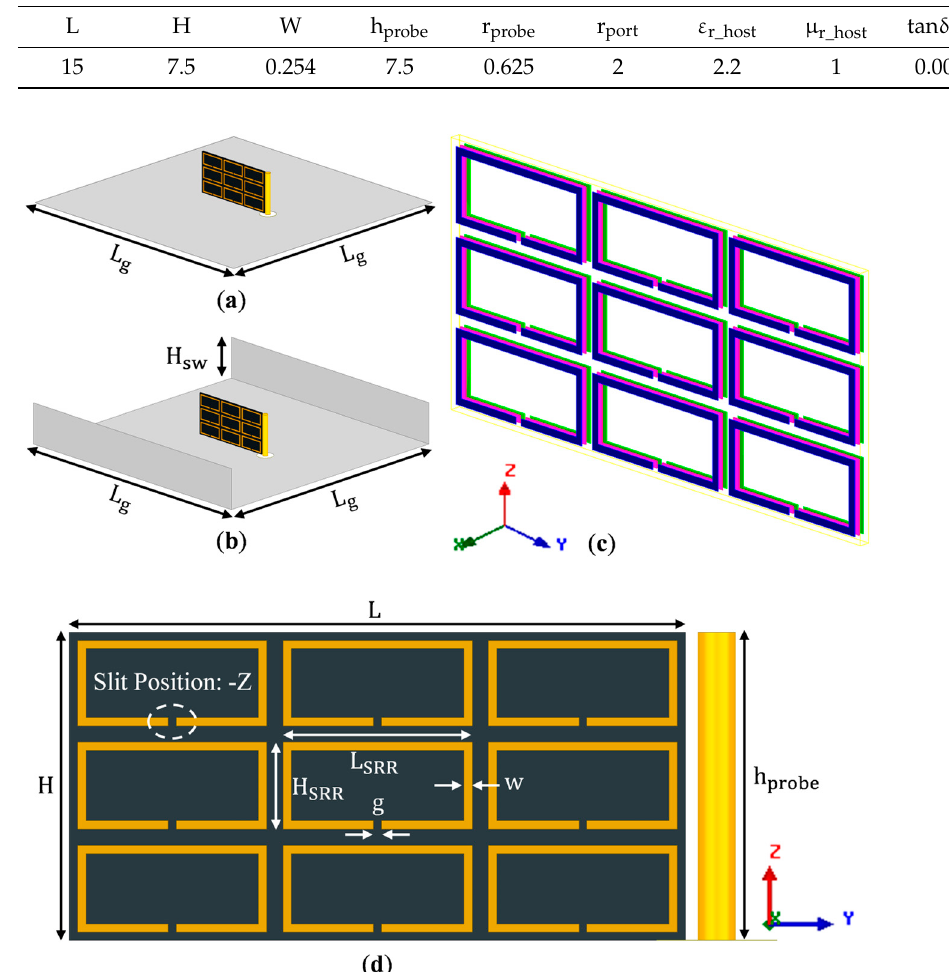
Figure 2. ( a ) Oblique view of an SRR array embedded in the host substrate with 3 elements in all 3 directions of X, Y, and Z, denoted as 3𝑥⃑ × 3𝑦⃑ × 3𝑧⃑ , placed on a conventional planar ground plane ( Host substrate; SRRs and probe; Ground plane). ( b ) Oblique view of the same antenna on a U-shaped ground plane. ( c ) Zoomed-in view of the ring arrangements on the substrate (different colors are used to demonstrate different layers of SRRs). The three identical layers of SRRs are placed on the front ( blue), center ( pink), and back ( green) surfaces. ( d ) Zoomed-in front view of the SRR array with dimensions as marked.